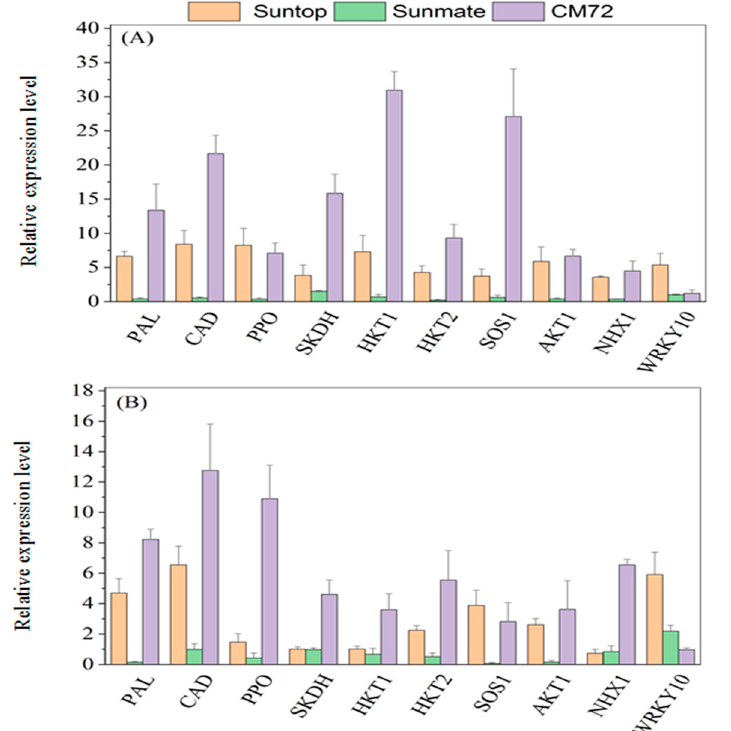
Figure 8. Relative expression levels (100 mM NaCl vs. control) of secondary metabolites-related genes, transporter and sequestration genes, and transcription factors in leaves ( A ) and roots ( B ) of Suntop, Sunmate, and CM72 under 100 mM NaCl. Seedlings were exposed to 100 mM salinity (NaCl) treatments for 7 days. Data are means ± SD (n = 3).